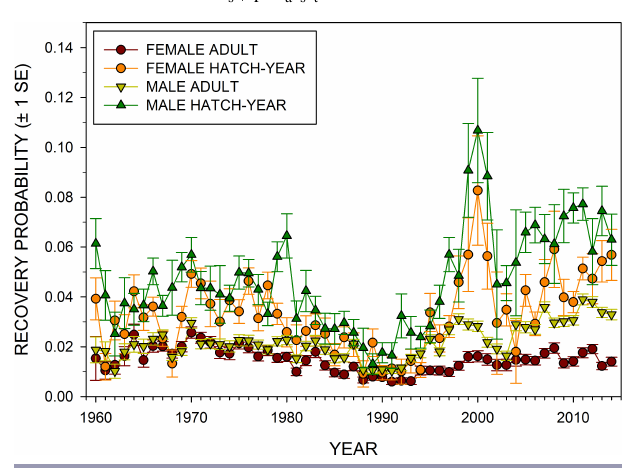
Fig. 7. Annual recovery rates ( f ) for Northern Pintail ( Anas acuta ) banded in Alberta and Saskatchewan, Canada (≤ 54° N latitude) from 1960–2014. Estimates of f are from the most parsimonious model S , f . s + T² a*s*t